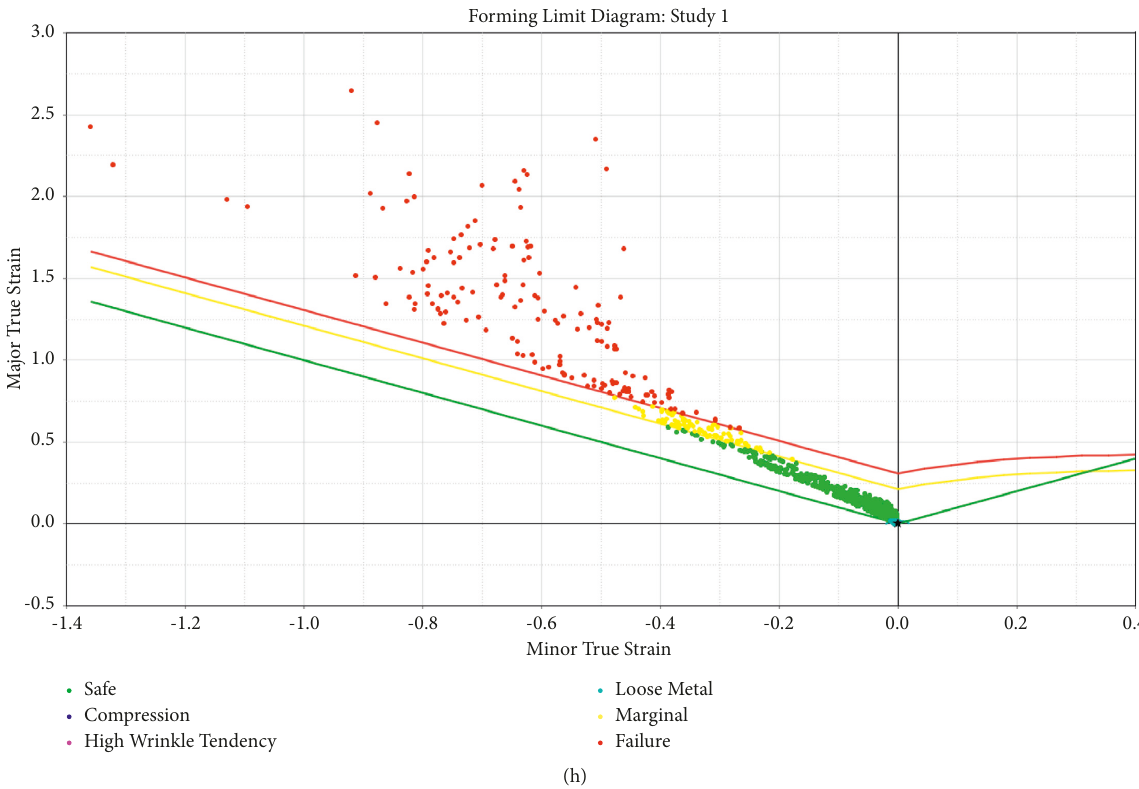
Figure 8: Contour plot and FLD of APA blank #6 (a, b), APA blank #10 (c, d), GPG blank #6 (e, f), and GPG blank #10 (g, h).